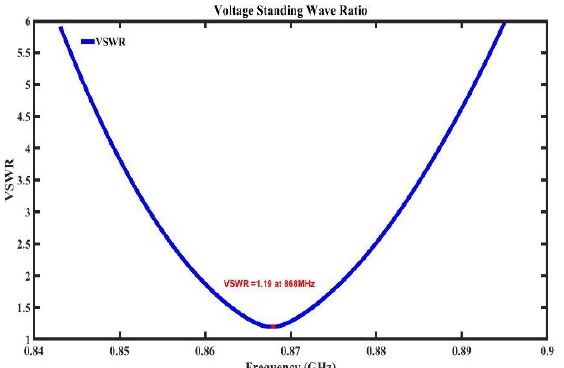
Fig.8. Simulated gain Vs Frequency /GHz of proposed RFID